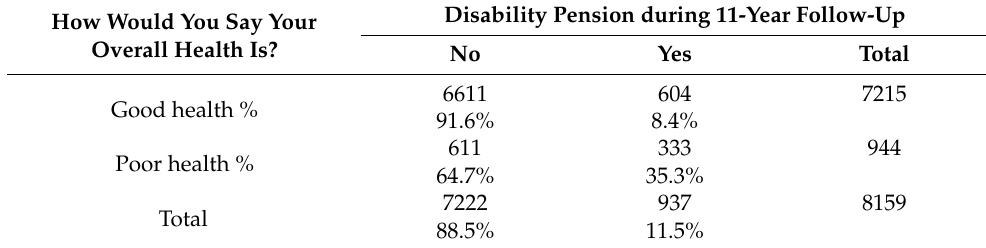
Table 1. Participants self-rated health and number of disability pensions.